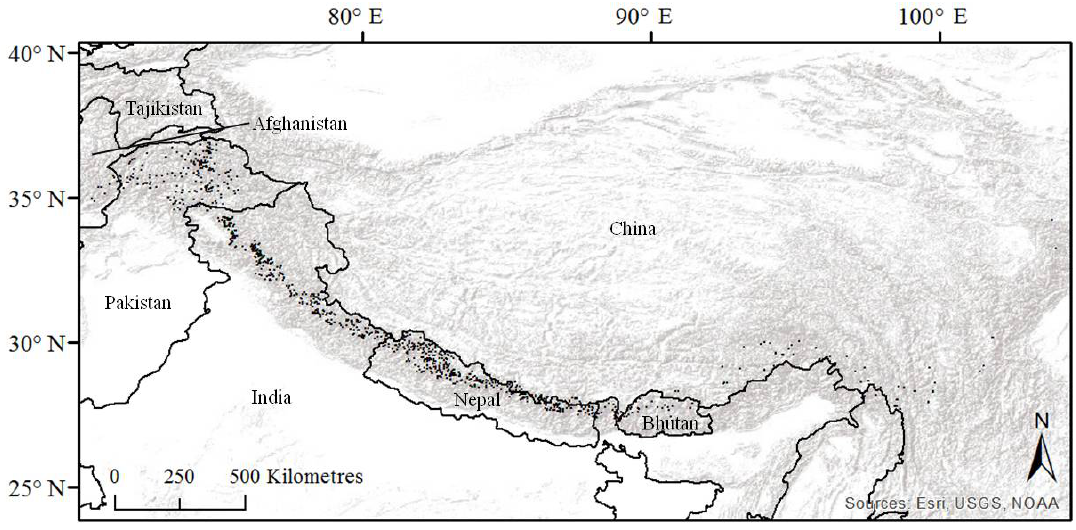
Figure 1. Occurrences of Betula utilis along the Himalayan arc ( N = 1041).